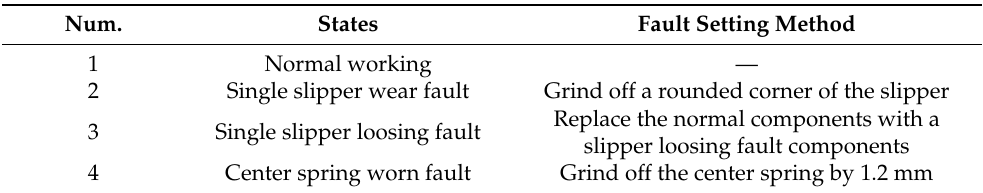
Table 2. Fault setting method of axial piston pump.